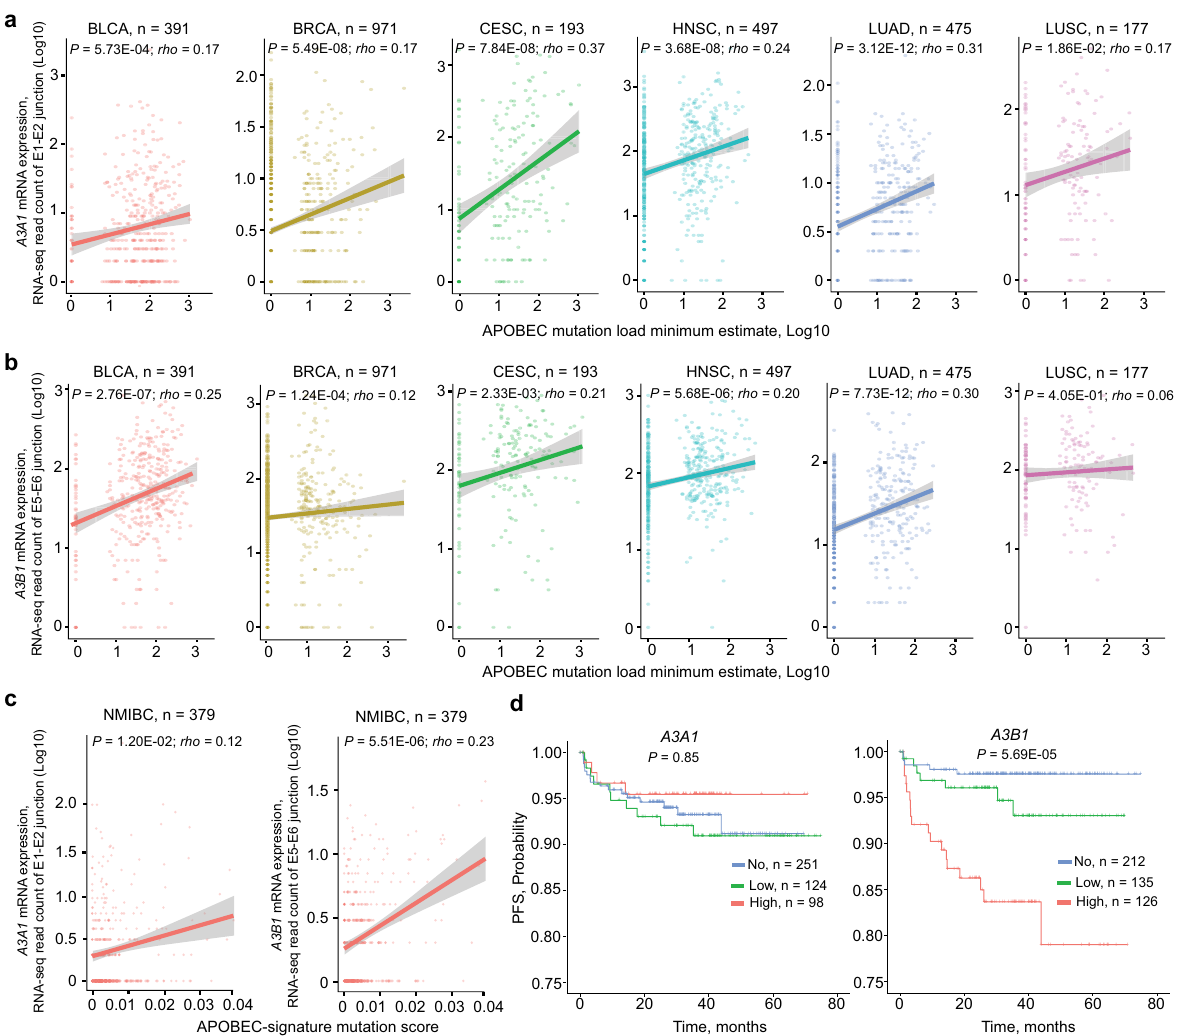
Fig. 3 Analysis of A3A1 and A3B1 expression based on exon – exon junction RNA-seq reads in relation to APOBEC-mediated mutagenesis and progression-free survival in patients with non-muscle-invasive bladder cancer (NMIBC). Correlation analysis between mRNA expression of a A3A1 and b A3B1 and APOBEC-mediated mutagenesis, measured as “ APOBEC mutation load minimum estimate ” in six cancer types in TCGA. Spearman correlation coef fi cients with P -values for two-sided tests are shown. The line in scatterplots represents the linear trend and the shading represents the 95% con fi dence interval around the line of best fi t. c Signi fi cant correlation between APOBEC-signature mutation score (S3) and A3B1 but not A3A1 expression in non- muscle-invasive bladder cancer (NMIBC) in the UROMOL study. d Kaplan – Meier plots for progression-free survival (PFS) of NMIBC based on A3A1 and A3B1 isoform expression in the UROMOL study. P -values are for multivariable Cox-regression models adjusted for sex, age, and tumor stage. Grouping into “ No ” , “ Low ” , and “ High ” groups was done based on A3B1 RNA-seq read counts, separating samples with no expression (zero reads) and then below and above the median for the remaining